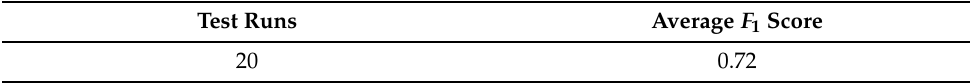
Table 8. ISFB Similarity Using Linux OpenSSL Features.